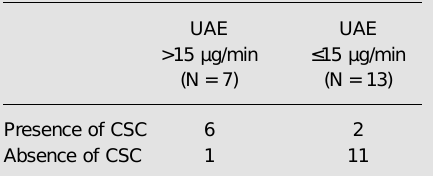
Table 4. Predictive value of urinary albumin excre- tion (UAE) regarding cardiac structural changes